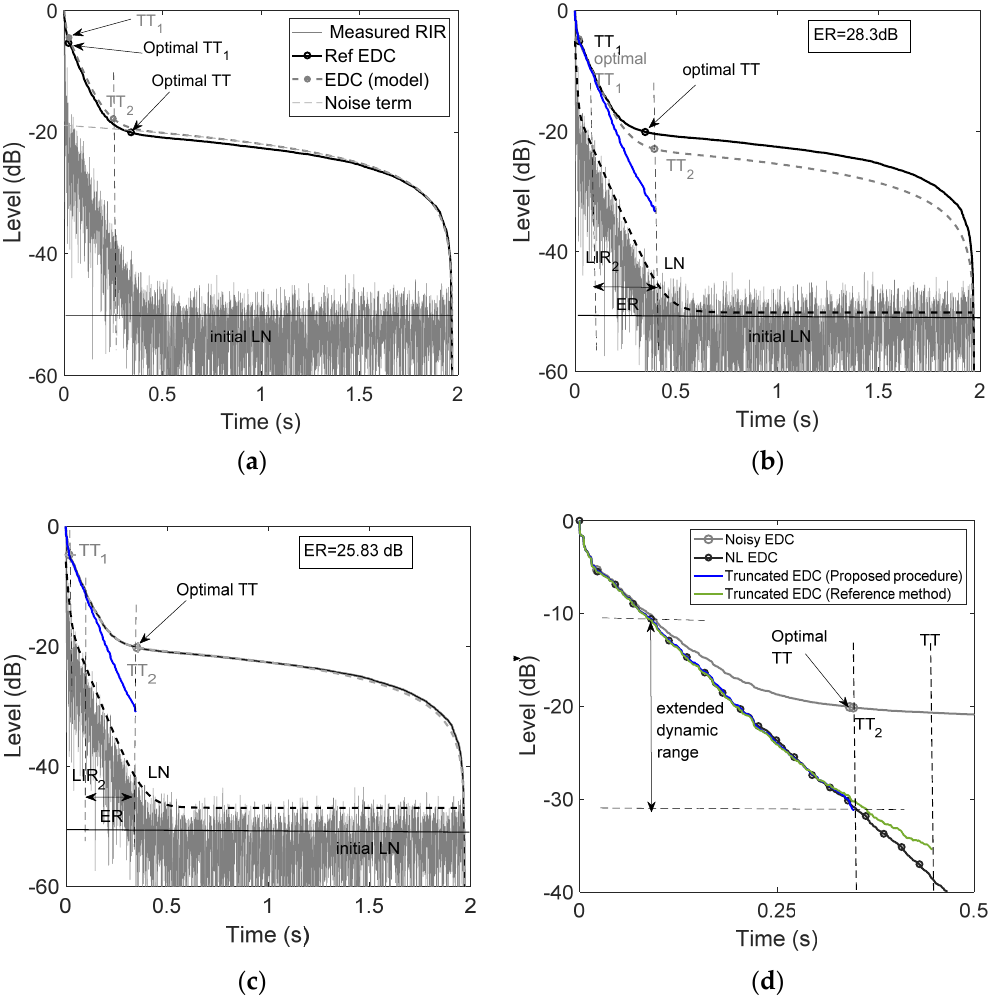
Figure 4. Comparison of the reference EDC and the EDC obtained from the model given in Equation (7) and corresponding TT 1 and TT 2 estimated in Equation (6) by implementing the proposed procedure in each step: ( a ) The EDC (gray dotted line) generated from the model by using the LS optimization together with the TT 1 and TT 2 ( b , c ) The EDC (gray dotted line) generated from the model by using the parameters from the previous step of the iterative procedure together with the TT 1 and TT 2 . ( d ) comparison of the EDC truncated at the TT 2 obtained from ( c ) and the EDC truncated at the 𝑇𝑇 given in Section 4.1.